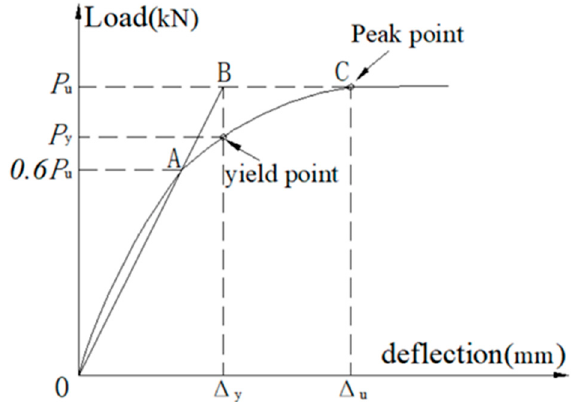
Figure 4. Park’s method. Figure 4. Park’s